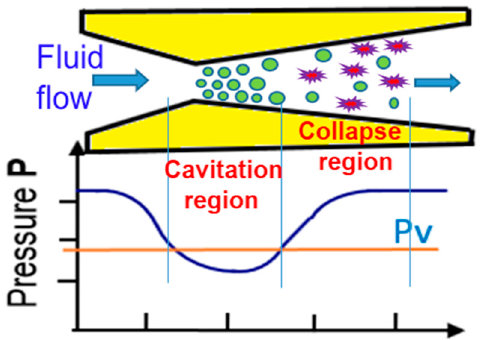
Figure 1. Cavitation in a Venturi tube.